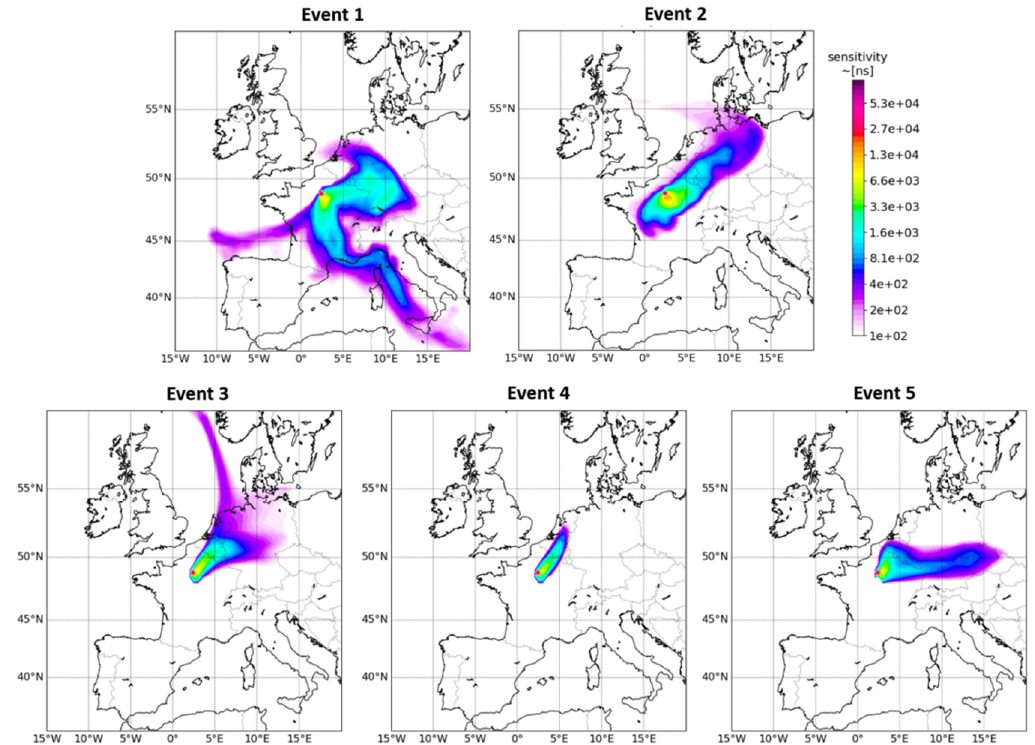
Figure 4. FLEXPART emission sensitivity response functions to air parcels reaching the Paris region (red dot) during the five pollution events.